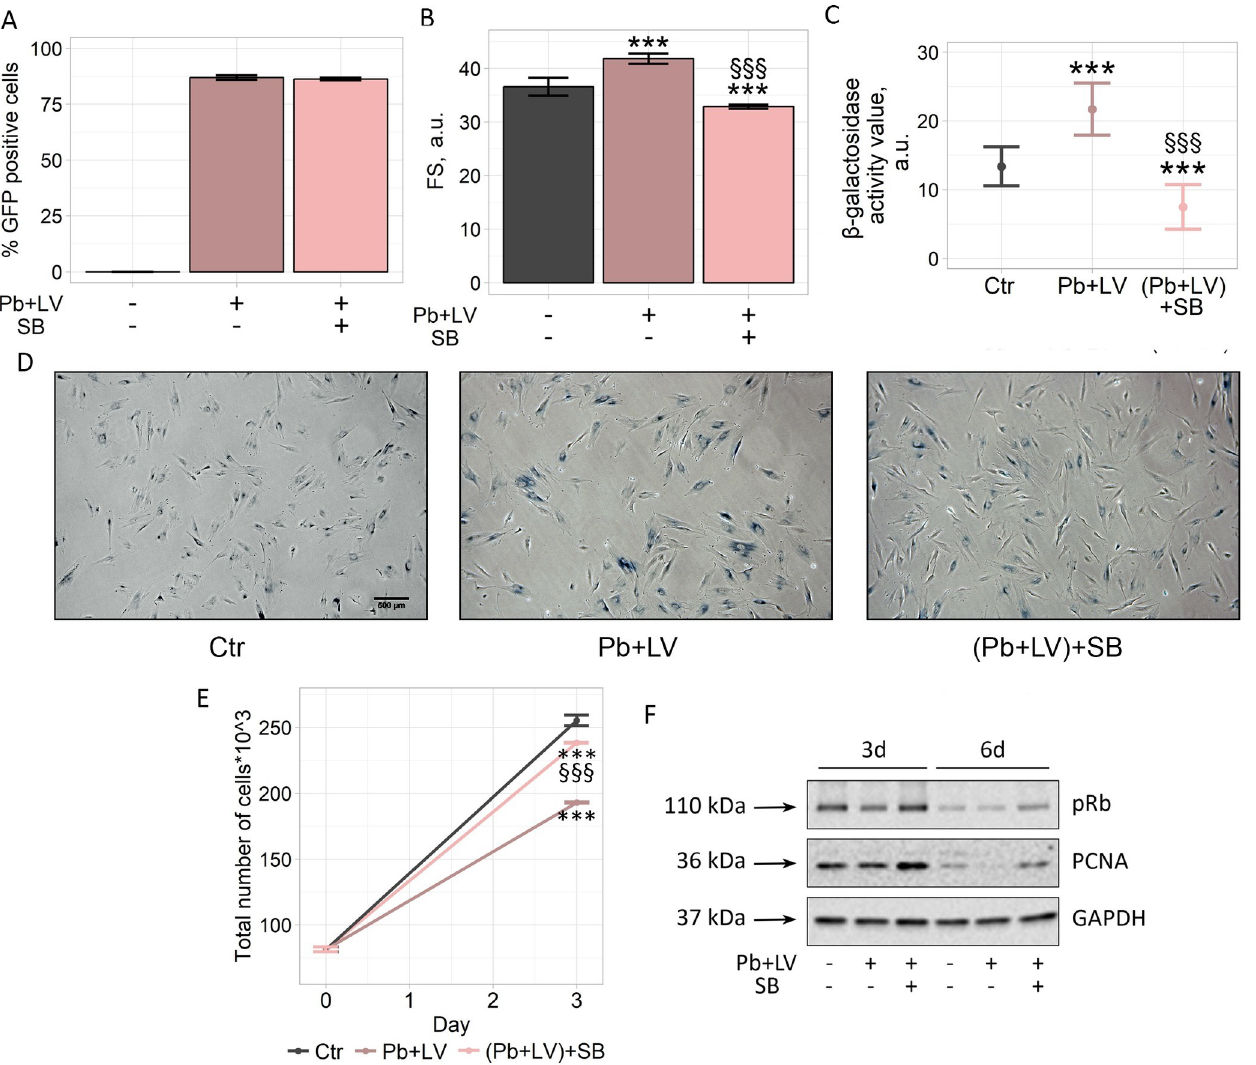
Fig 5. p38 MAPK inhibition reduces negative impact of Pb on the main hMESCs properties during LV transduction. “Ctr”–control cells. “Pb+LV”–the cells infected by LV with 4 μ g/ml of Pb. “(Pb+LV)+SB”–the cells infected by LV with 4 μ g/ml of Pb additionally supplied with 5 μ M SB. (A). The effectiveness of hMESCs transduction estimated by FACS analysis of the green fluorescence intensity. (B) Cell size. (C, D) SA- β -Gal quantification and staining. Scale bar is 500 μ m and valid for all images. (E) Growth curves. (F) Rb phosphorylation and PCNA protein expression at indicated time points. GAPDH was used as loading control. All results are representatives of at least three independent